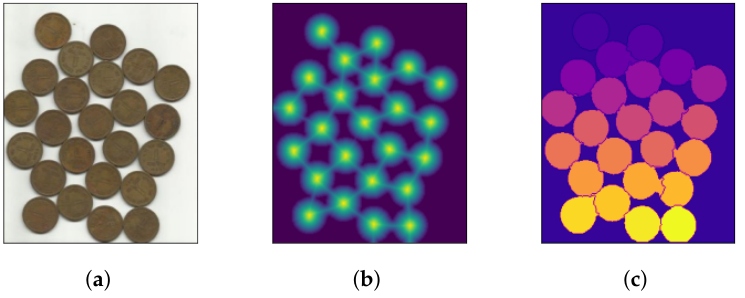
Figure 4. Watershed algorithm functionality in three steps. ( a ) overlapping objects; ( b ) distances; ( c ) segmented